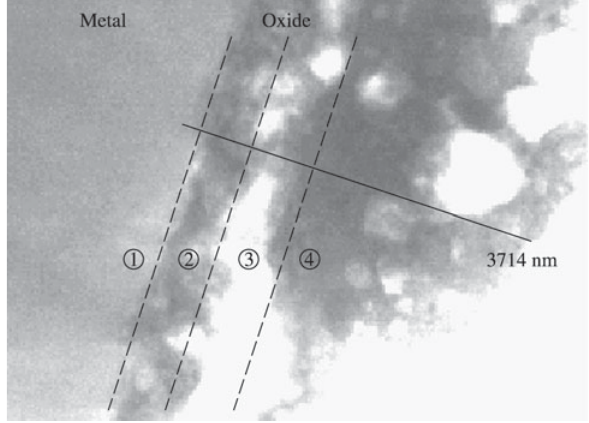
Figure 3 . Transmission electron micrograph of anodic film formed at 90 V on AZ91HP in HAE-electrolyte. Photo in STEM-mode. The line on the photo shows the way of the line-scan in Fig. 4. (cid:99) : Mg alloy; (cid:100) : inner dense layer containing F- and P-enriched zone; (cid:101) : highly porous zone separating inner and outer layer; (cid:102) : outer porous layer with large